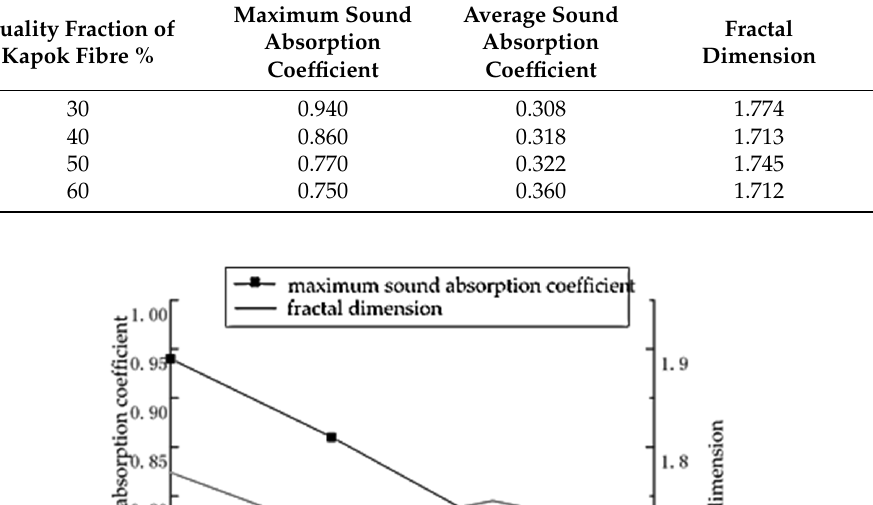
Table 2. Relevant parameters of samples under different kapok fibre mass fractions.